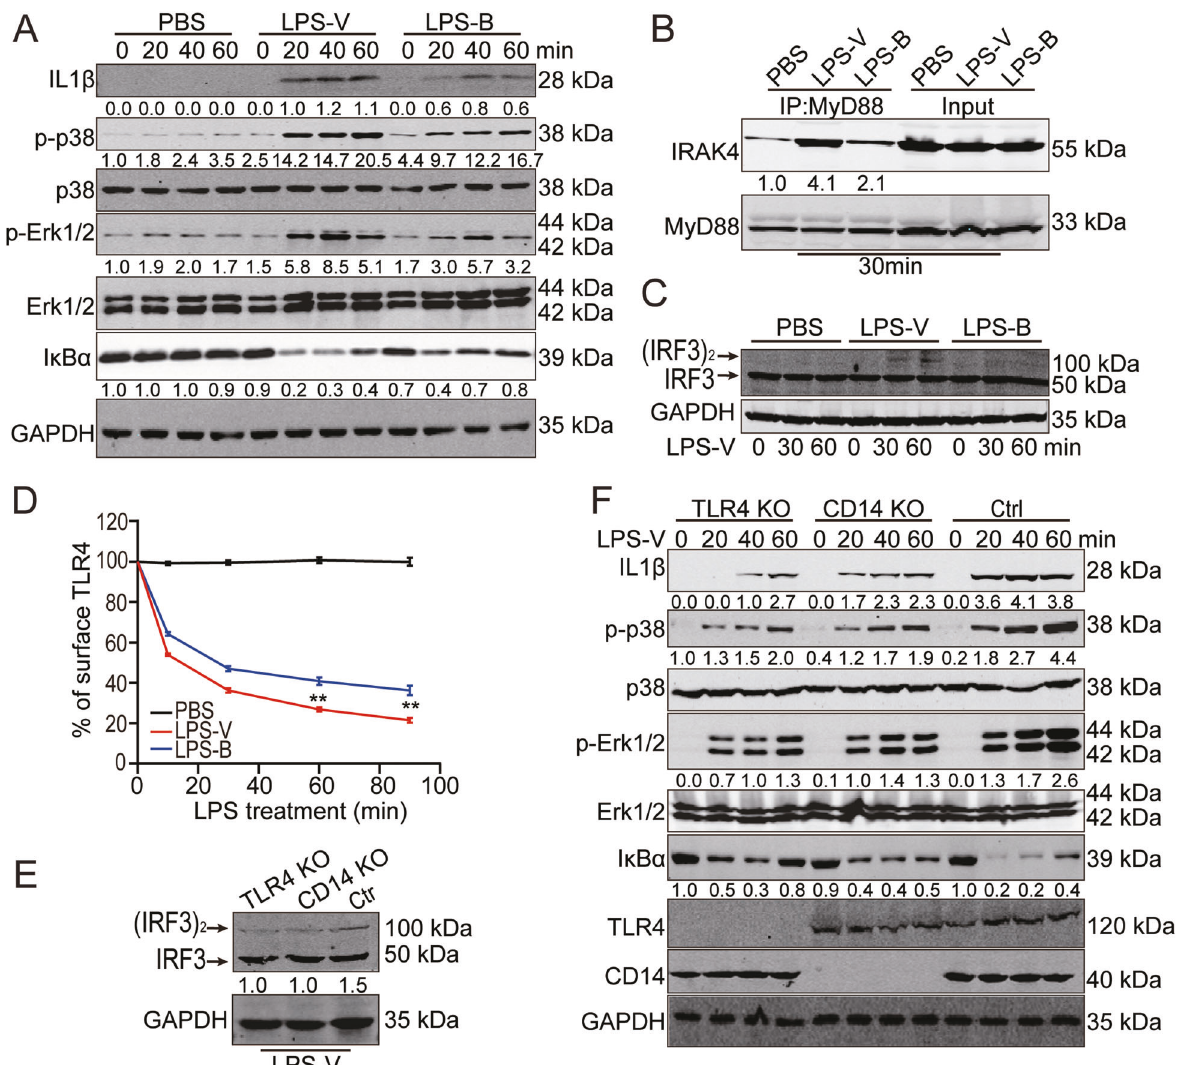
Fig. 5 LPS-V activated macrophages through TLR4 signaling. A Western blotting assays showing IL-1 β and TNF- α as well as MyD88- dependent changes in I κ B α levels, p-p38, and p-ERK1/2 at indicated time points of treatment with LPS (1 μ g/ml) in BMDMs. B IP and